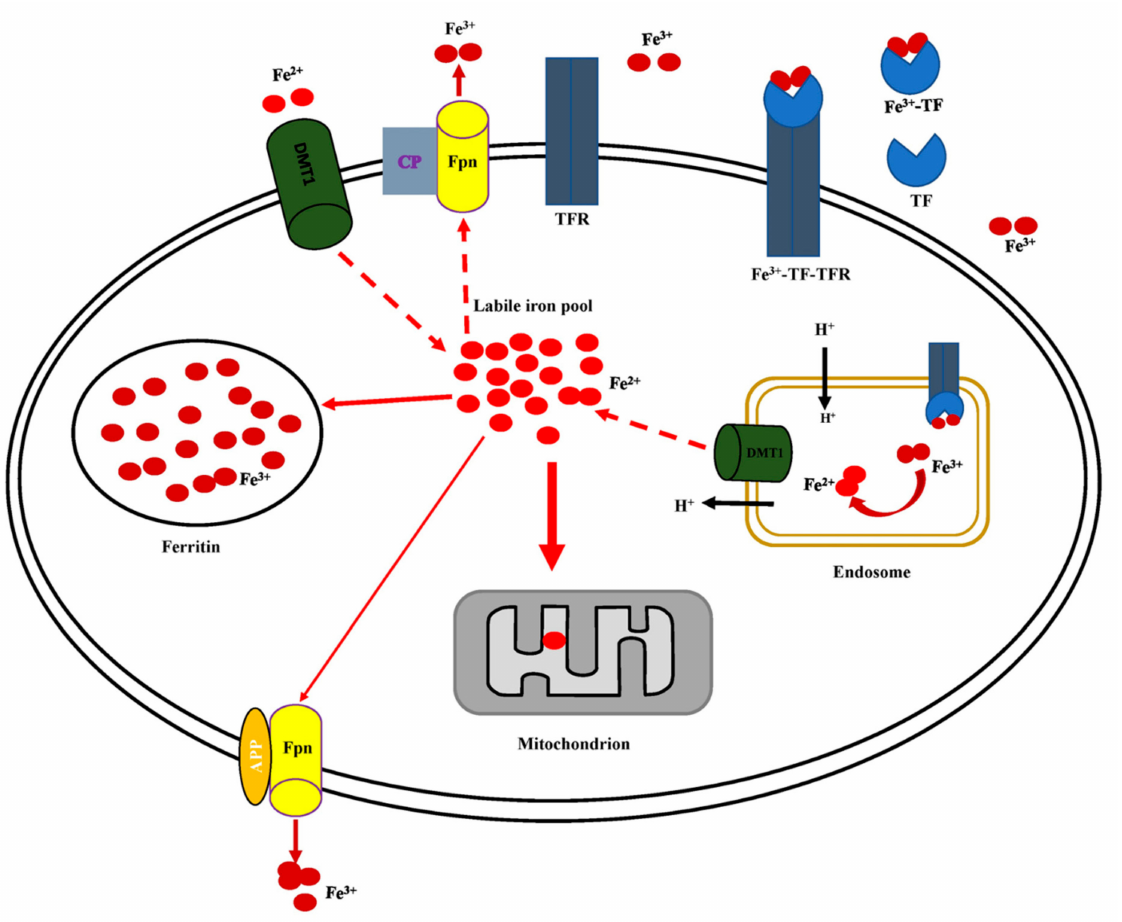
Figure 3. Cellular iron uptake, storage, utilization, and efflux. Extracellular Fe 2+ is converted to Fe 3+ through the activity of ceruloplasmin (CP). Two atoms of Fe 3+ binds to circulating transferrin (TF) and form a Fe 3+ -TF complex. The Fe 3+ -TF complex binds to the transferrin receptor (TFR) and the ternary Fe 3+ -TF-TFR complex is transported inside the cell to the endosome where Fe 3+